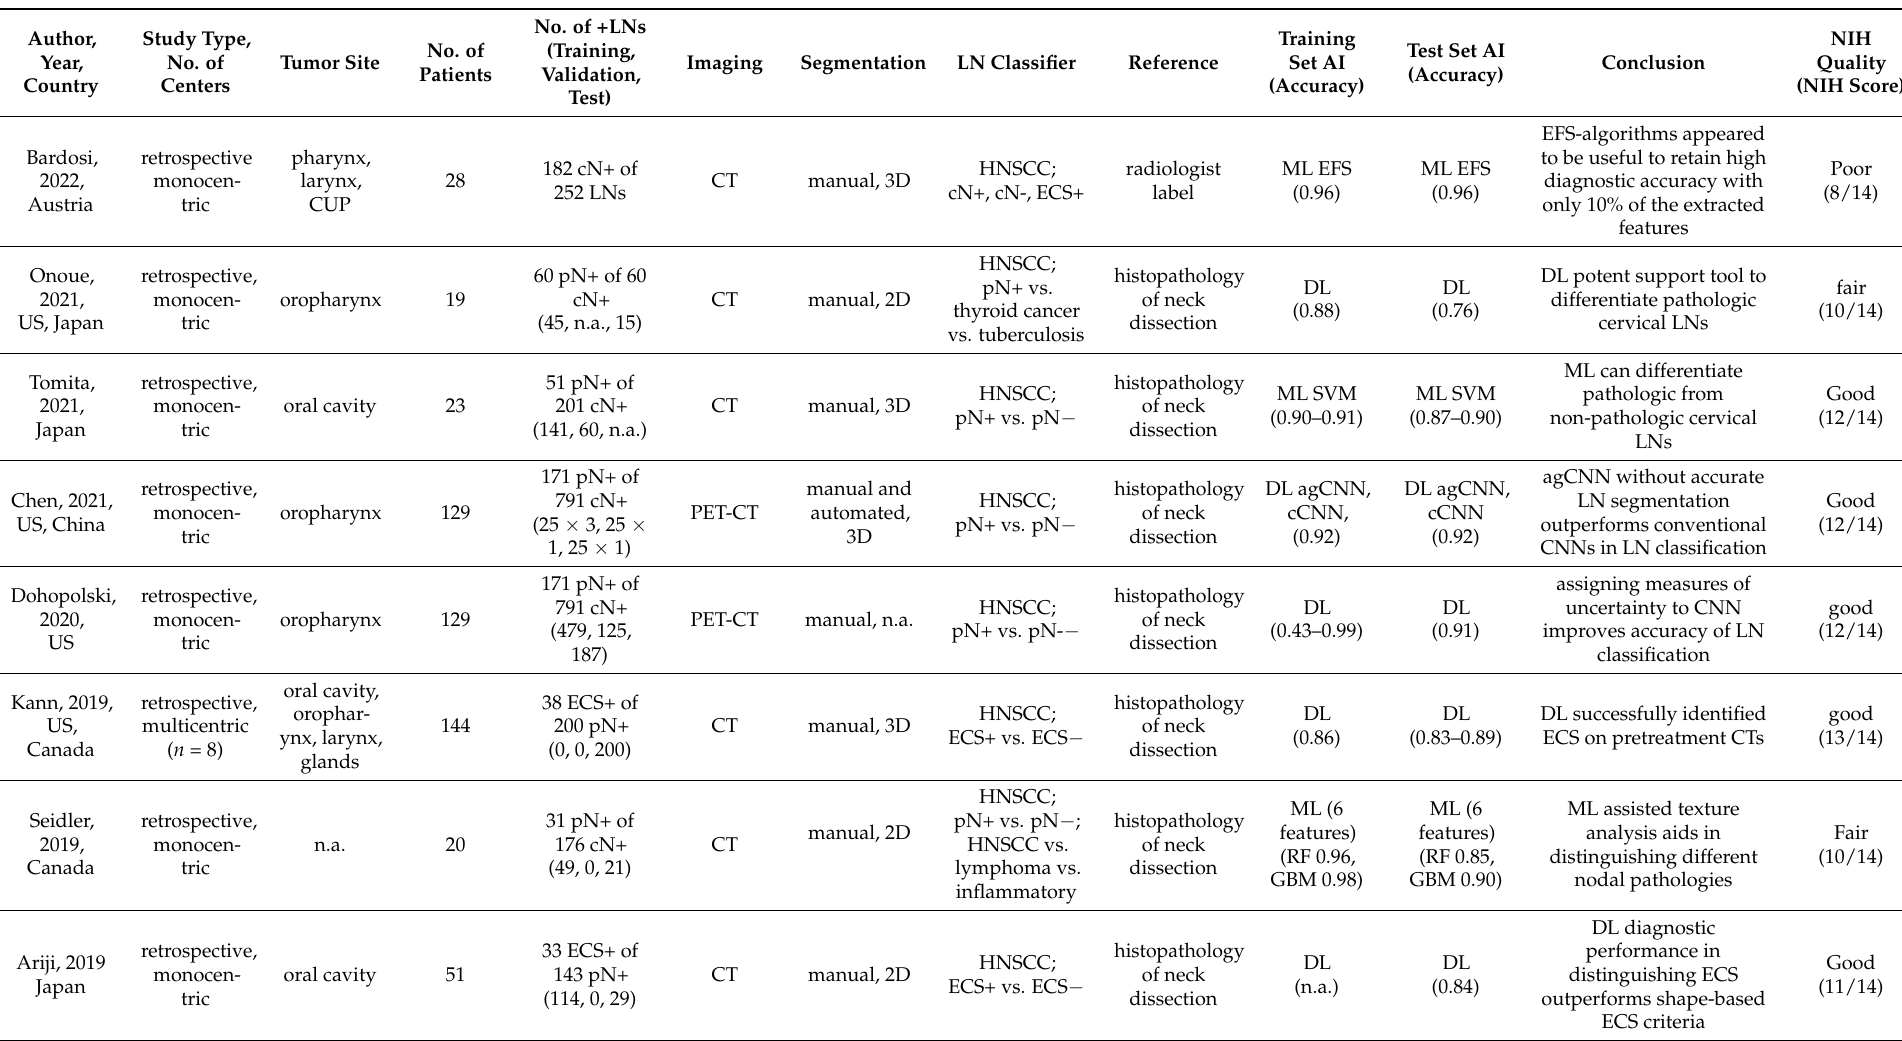
Table 3. Classification of cervical lymph nodes applying artificial